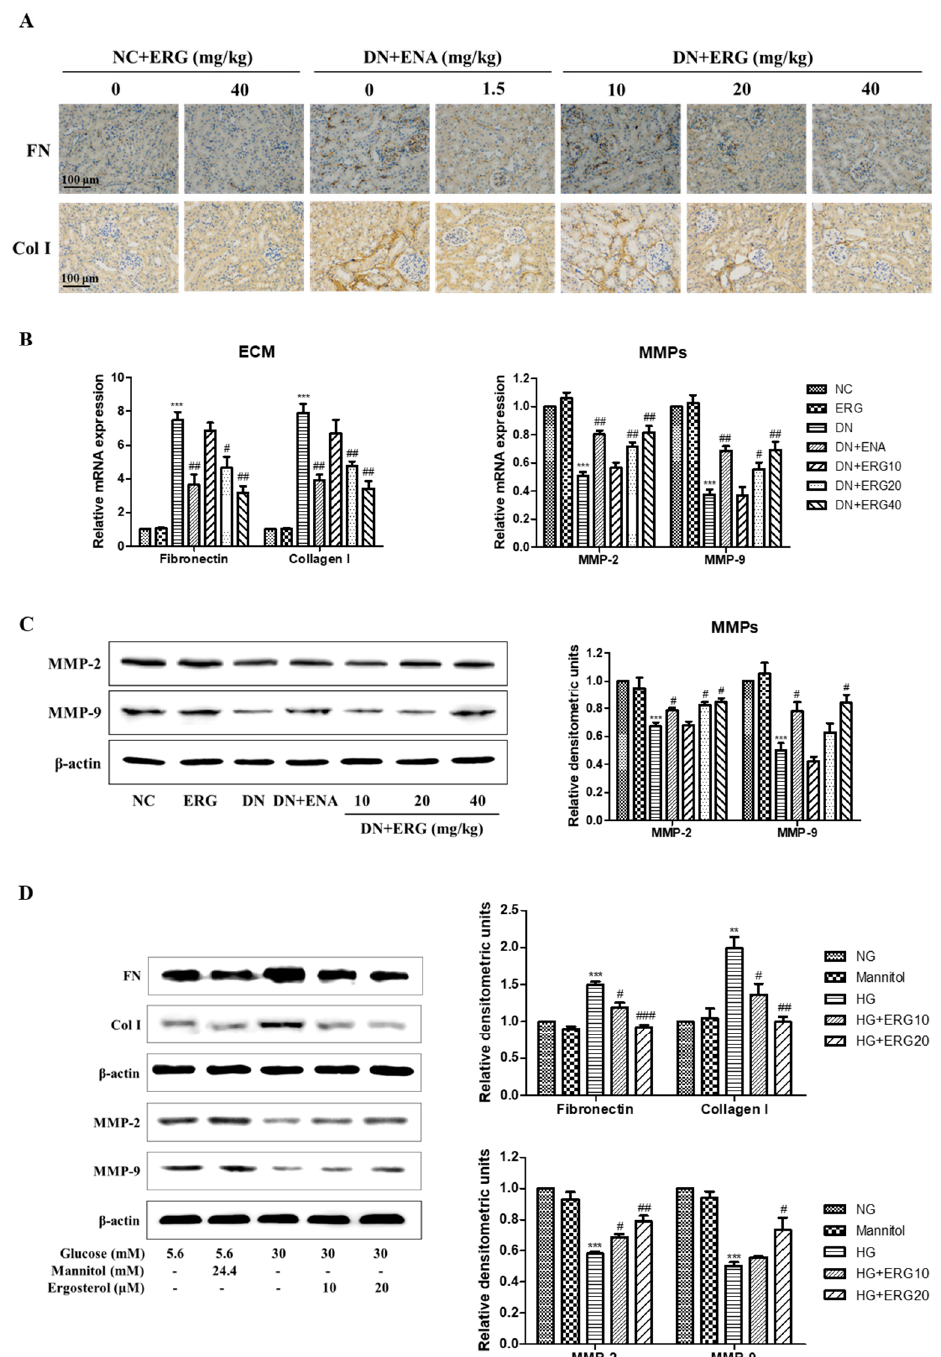
Figure 5. Ergosterol alleviated extracellular matrix (ECM) accumulation. ( A ) Representative renal sections with immunohistochemical staining of fibronectin and collagen I. ( B ) Expression of fibronectin, collagen I, MMP-2, and MMP-9 mRNA levels in renal parenchyma (data are presented as the means ± SD, n = 3). ( C ) Expression of MMP-2 and MMP-9 protein levels in renal parenchyma through Western blotting (data are presented as the means ± SD, n = 3). ( D ) Expression levels of fibronectin, collagen I, MMP-2 and MMP-9 in RMCs cultured under different conditions through Western blotting (data are presented as the means ± SD, triplicate). NC: normal control; DN: diabetic nephropathy model induced by STZ; ENA: positive control, 1.5 mg/kg/day enalaprilat administration; ERG10, ERG20, ERG40: 10, 20, 40 mg/kg/day ergosterol administration, respectively. NG: normal glucose, 5.6 mM glucose; Mannitol: 5.6 mM glucose + 24.4 mM mannitol; HG: high glucose, 30 mM glucose; ERG10 and ERG 20: 10 and 20 μ M ergosterol, respectively. ** p <0.01, *** p <0.001 compared with NG or NC; # p <0.05, ## p <0.01, ### p <0.001 compared with HG or DN.